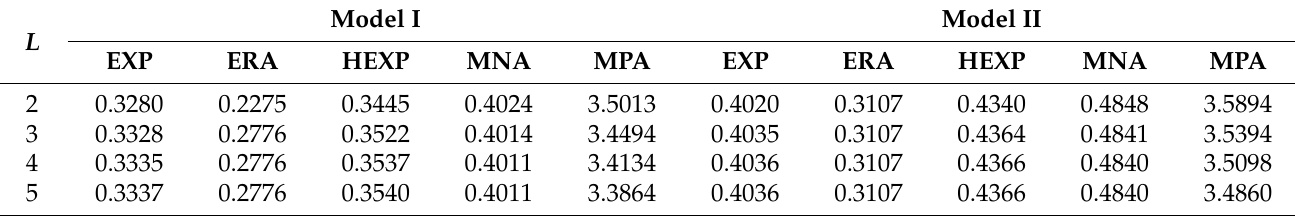
Table 2. Effect of L on expected number of P 2 customers in the system (when θ = 0.6).